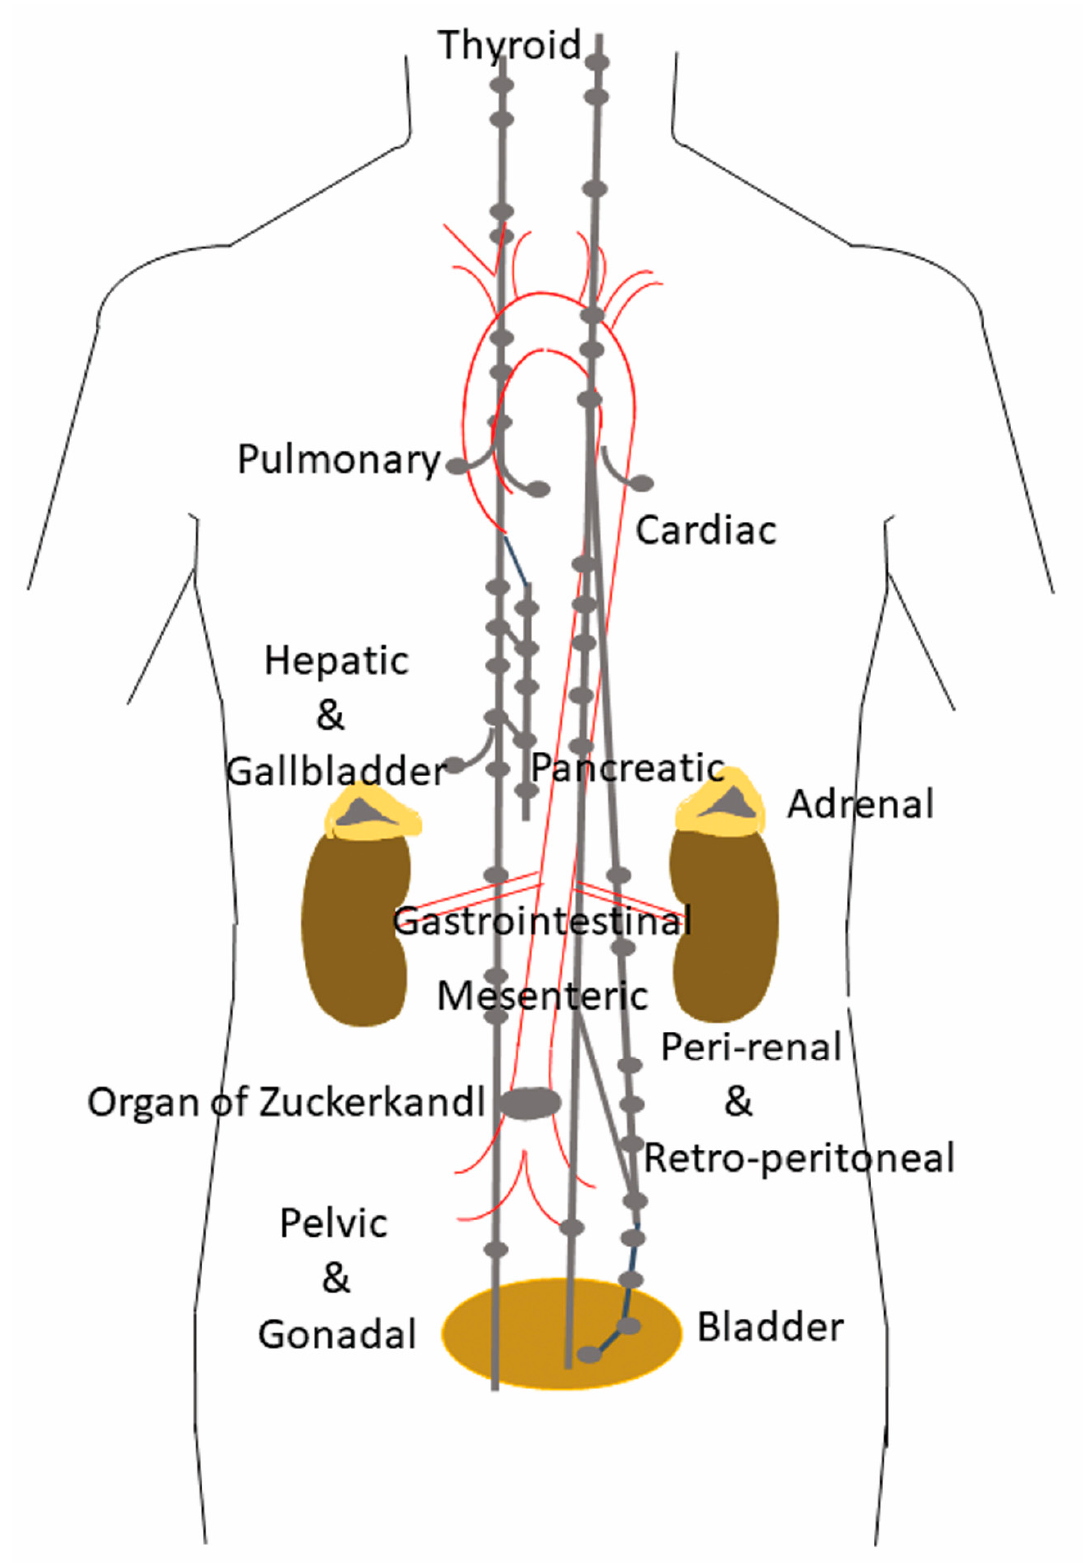
Figure 1. Location of paraganglia. This figure illustrates the location of normal paraganglia in the thorax and abdomen. Locations in the head are not neck, thorax and abdomen. Locations in the head are not shown.